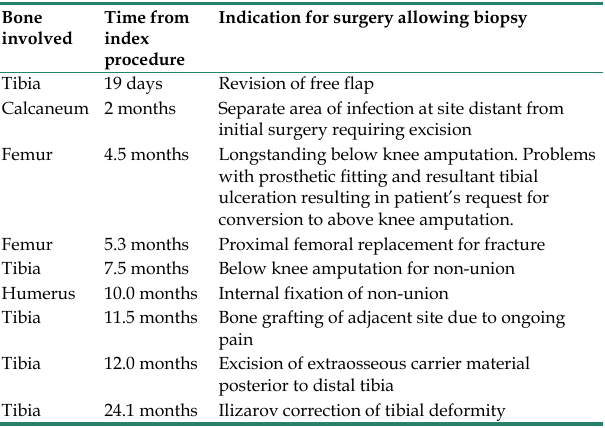
Table 3. Details of cases in which a biopsy of the CERAMENT ® |G was